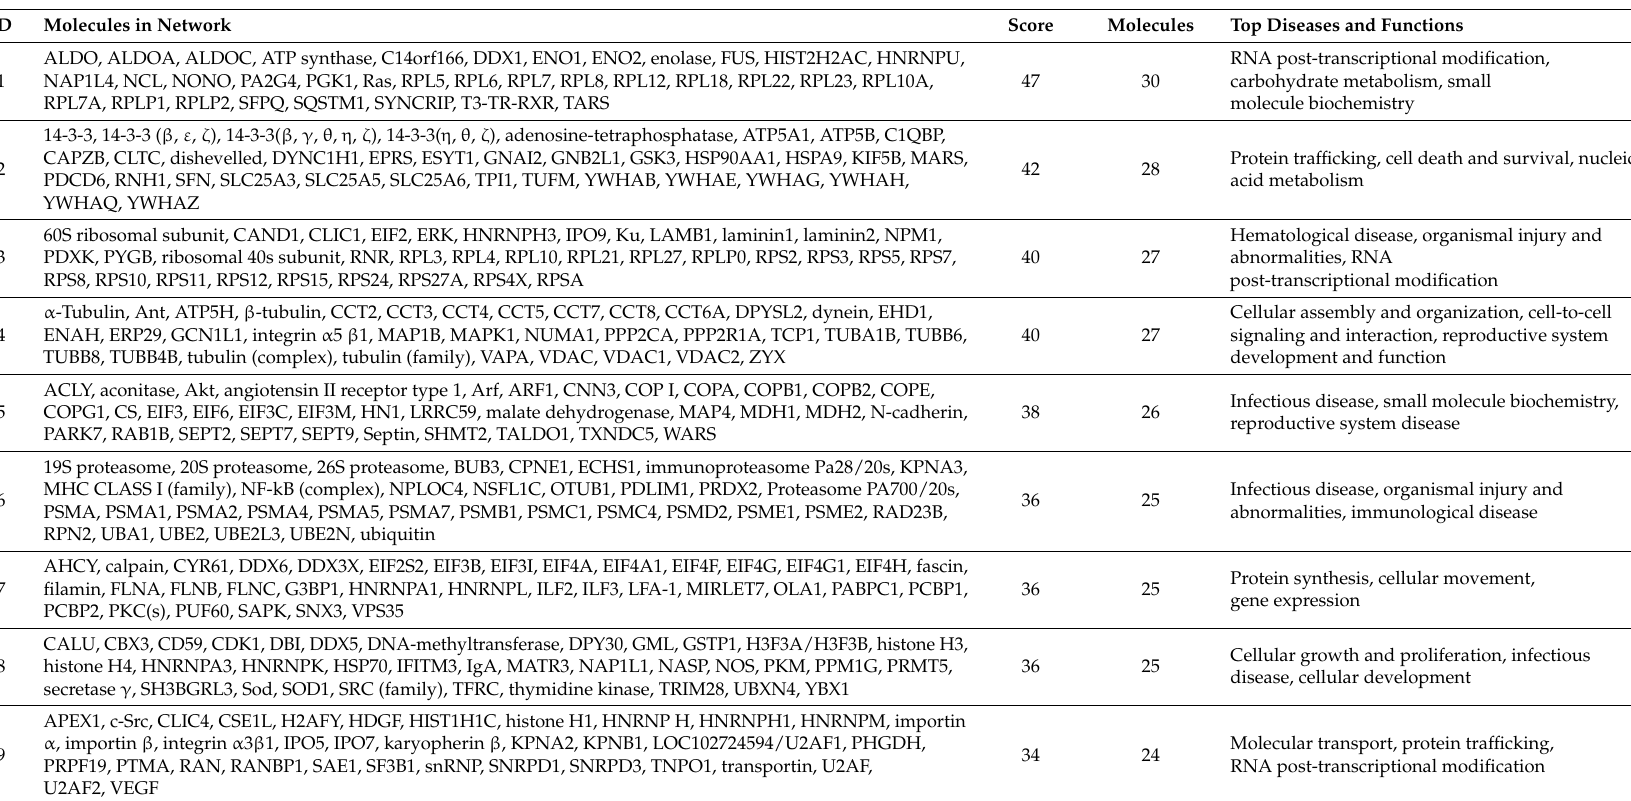
Table 4. 24 networks of molecular signaling pathway regulated by vancomycin in HK-2